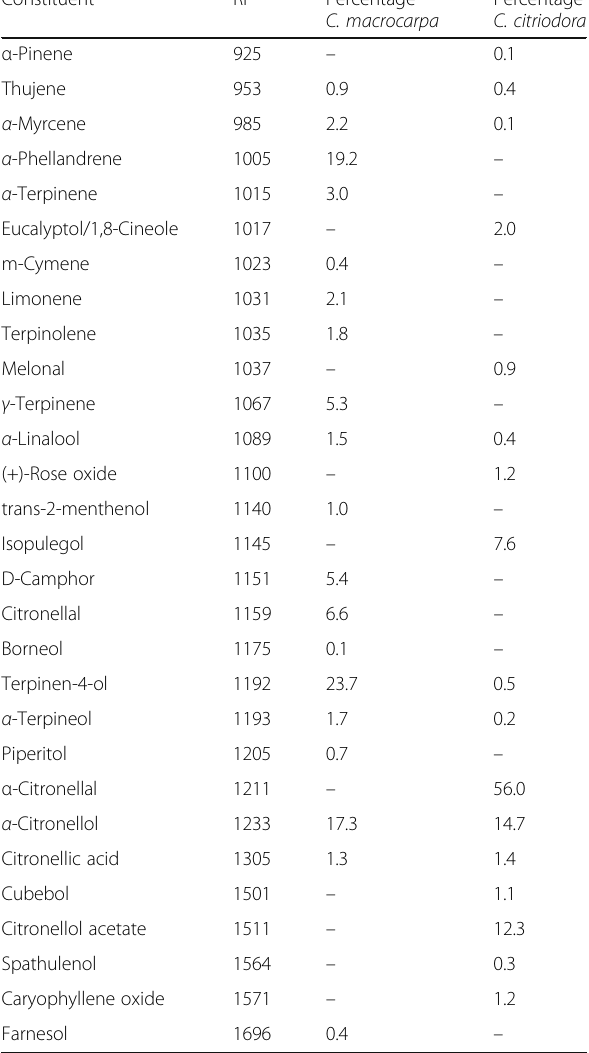
Table 1 Essential oil constituents of C. macrocarpa branchlets and C. citriodora